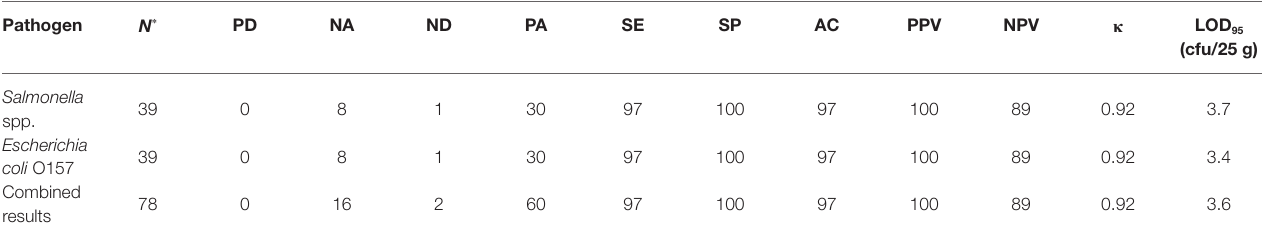
TABLE 2 | Summary of the fitness-for-purpose for each pathogen and the combined